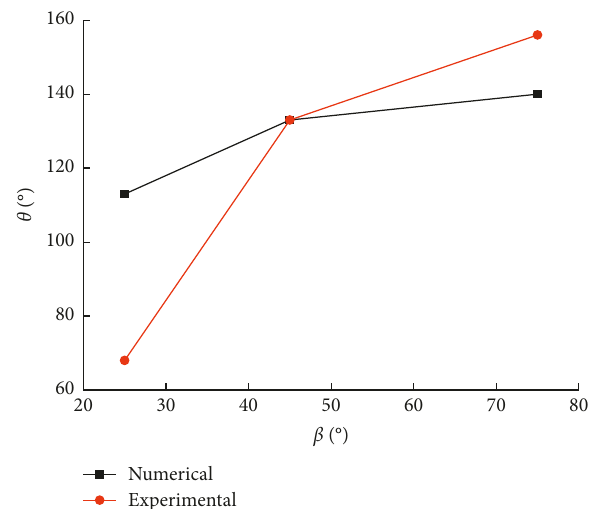
Figure 10: Relation of the inclination angle and the initiation